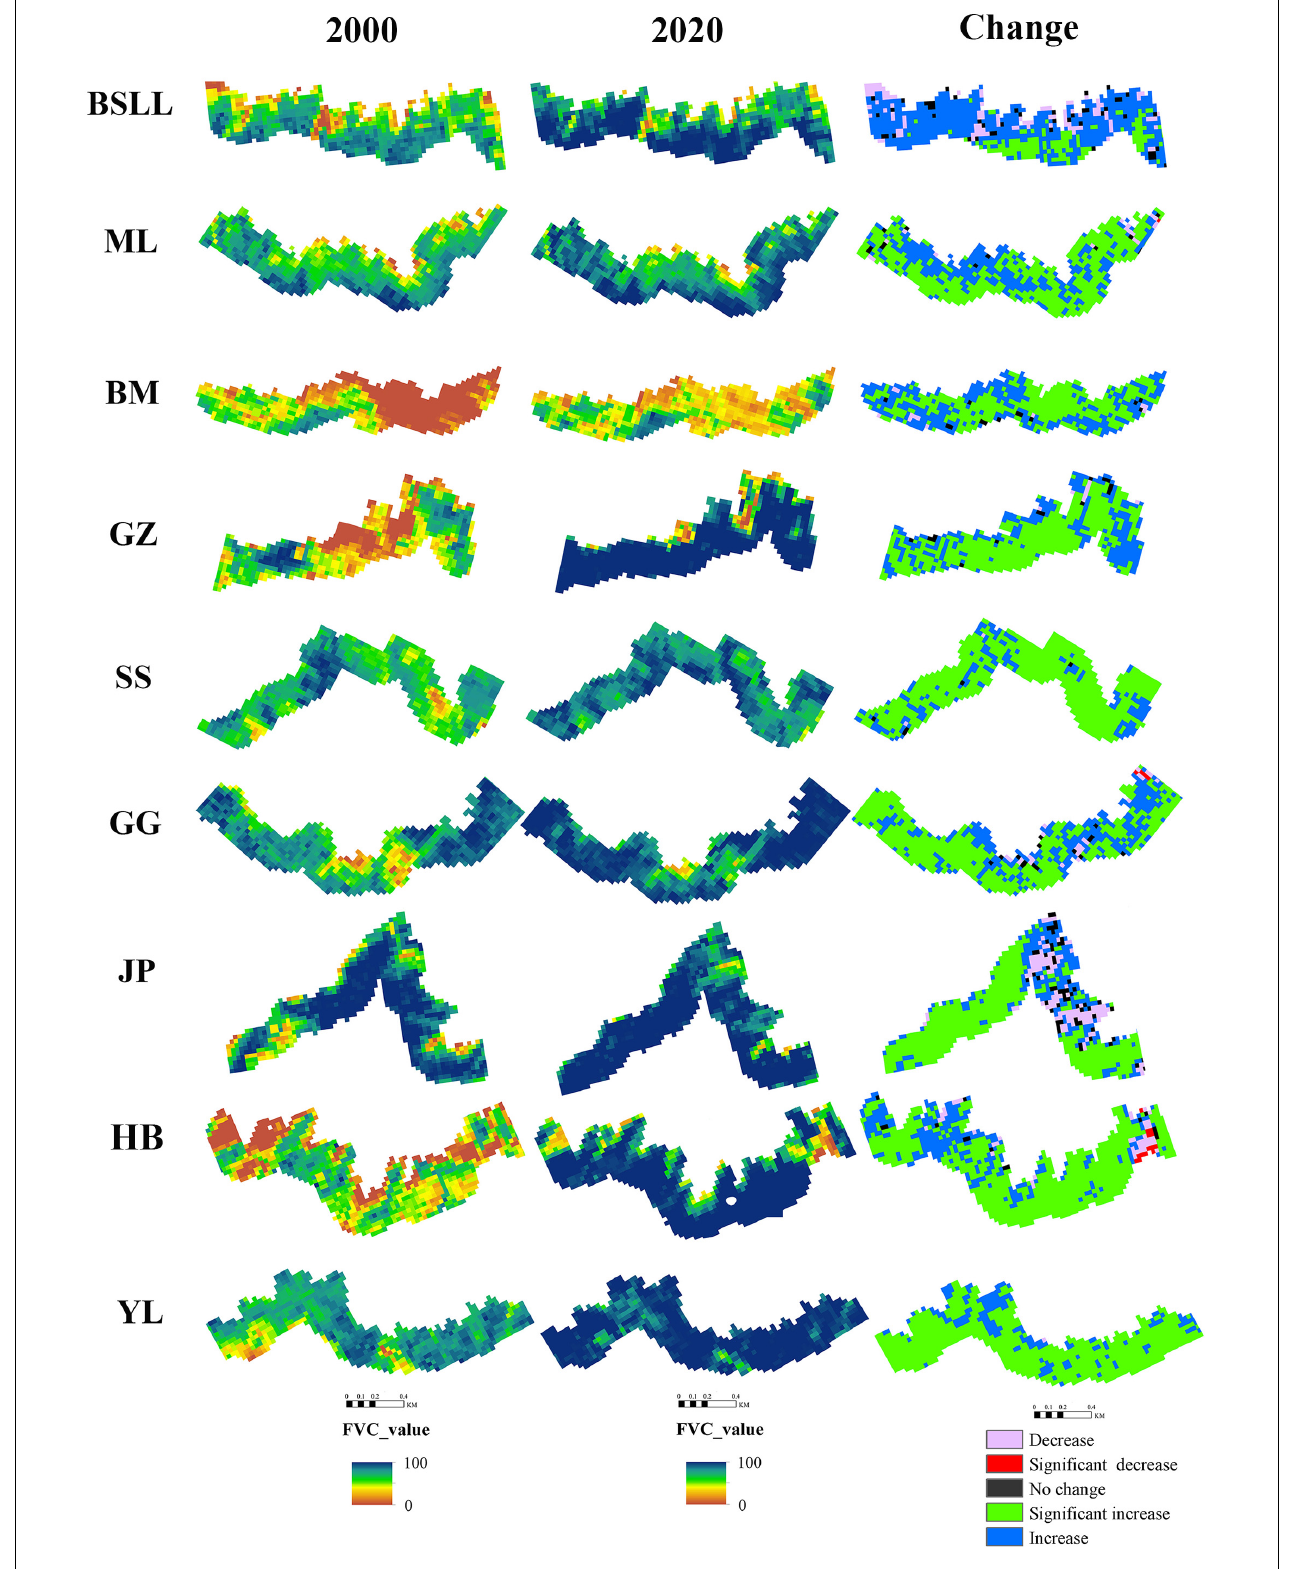
FIGURE 7 | Changes of the fraction vegetation cover in parts of each mountain range.